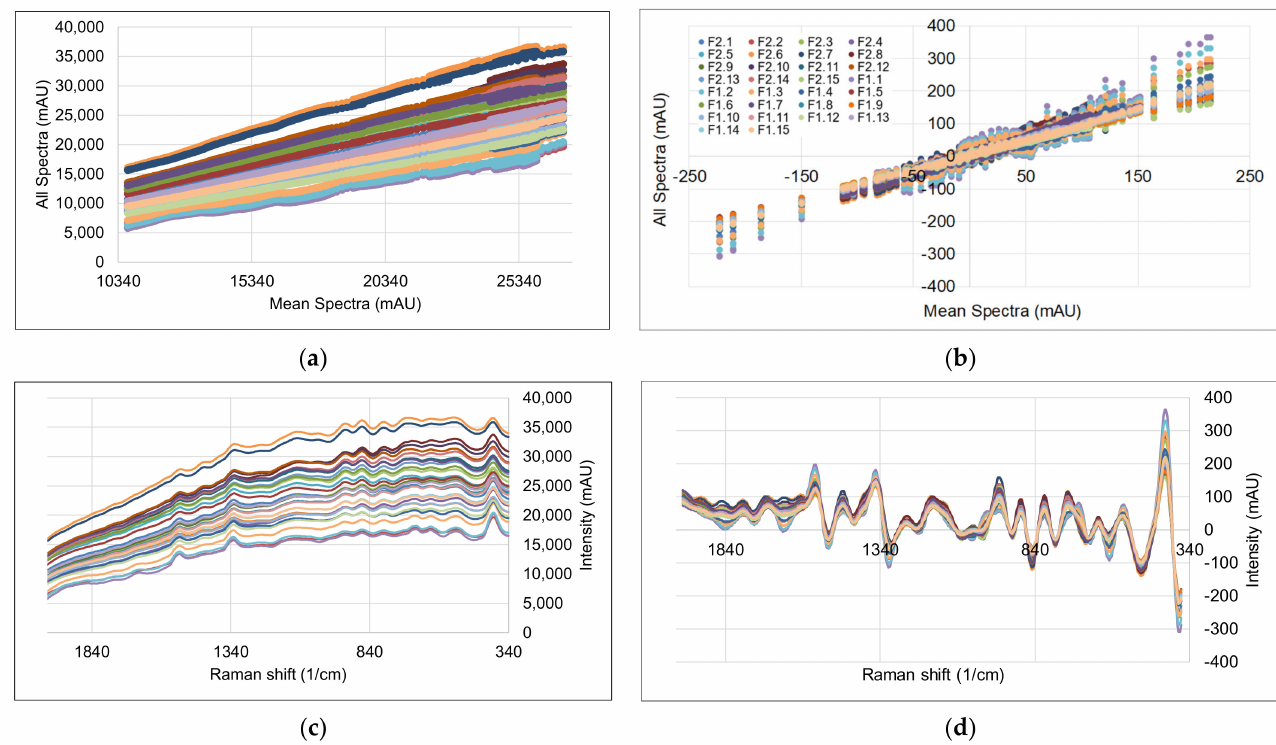
Figure 7. ( a ) Scatter effects of Raman spectra before and ( b ) after preprocessing; ( c ) data of Raman spectra before and ( d ) after preprocessing, legend from ( b ) applies for all